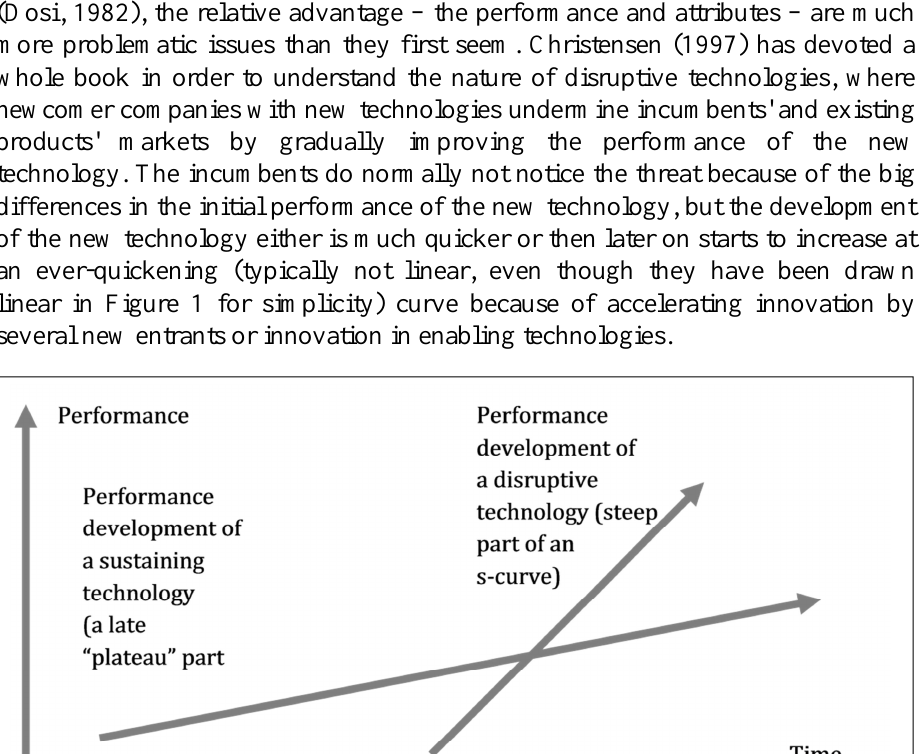
Figure 1. A simplified view to the sustaining and disruptive